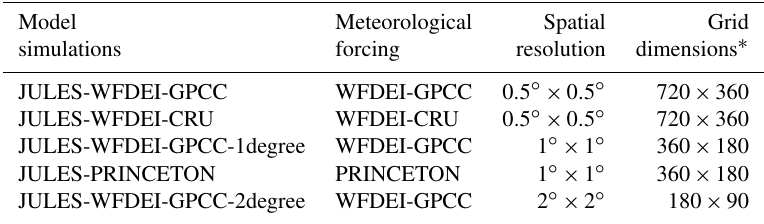
Table 1. Types of global-scale model simulations performed. Model Meteorological Spatial Grid simulations forcing resolution dimensions ∗ JULES-WFDEI-GPCC WFDEI-GPCC 0 . 5 ◦ × 0 . 5 ◦ 720 × 360 JULES-WFDEI-CRU WFDEI-CRU 0 . 5 ◦ × 0 . 5 ◦ 720 × 360 JULES-WFDEI-GPCC-1degree WFDEI-GPCC 360 × 180